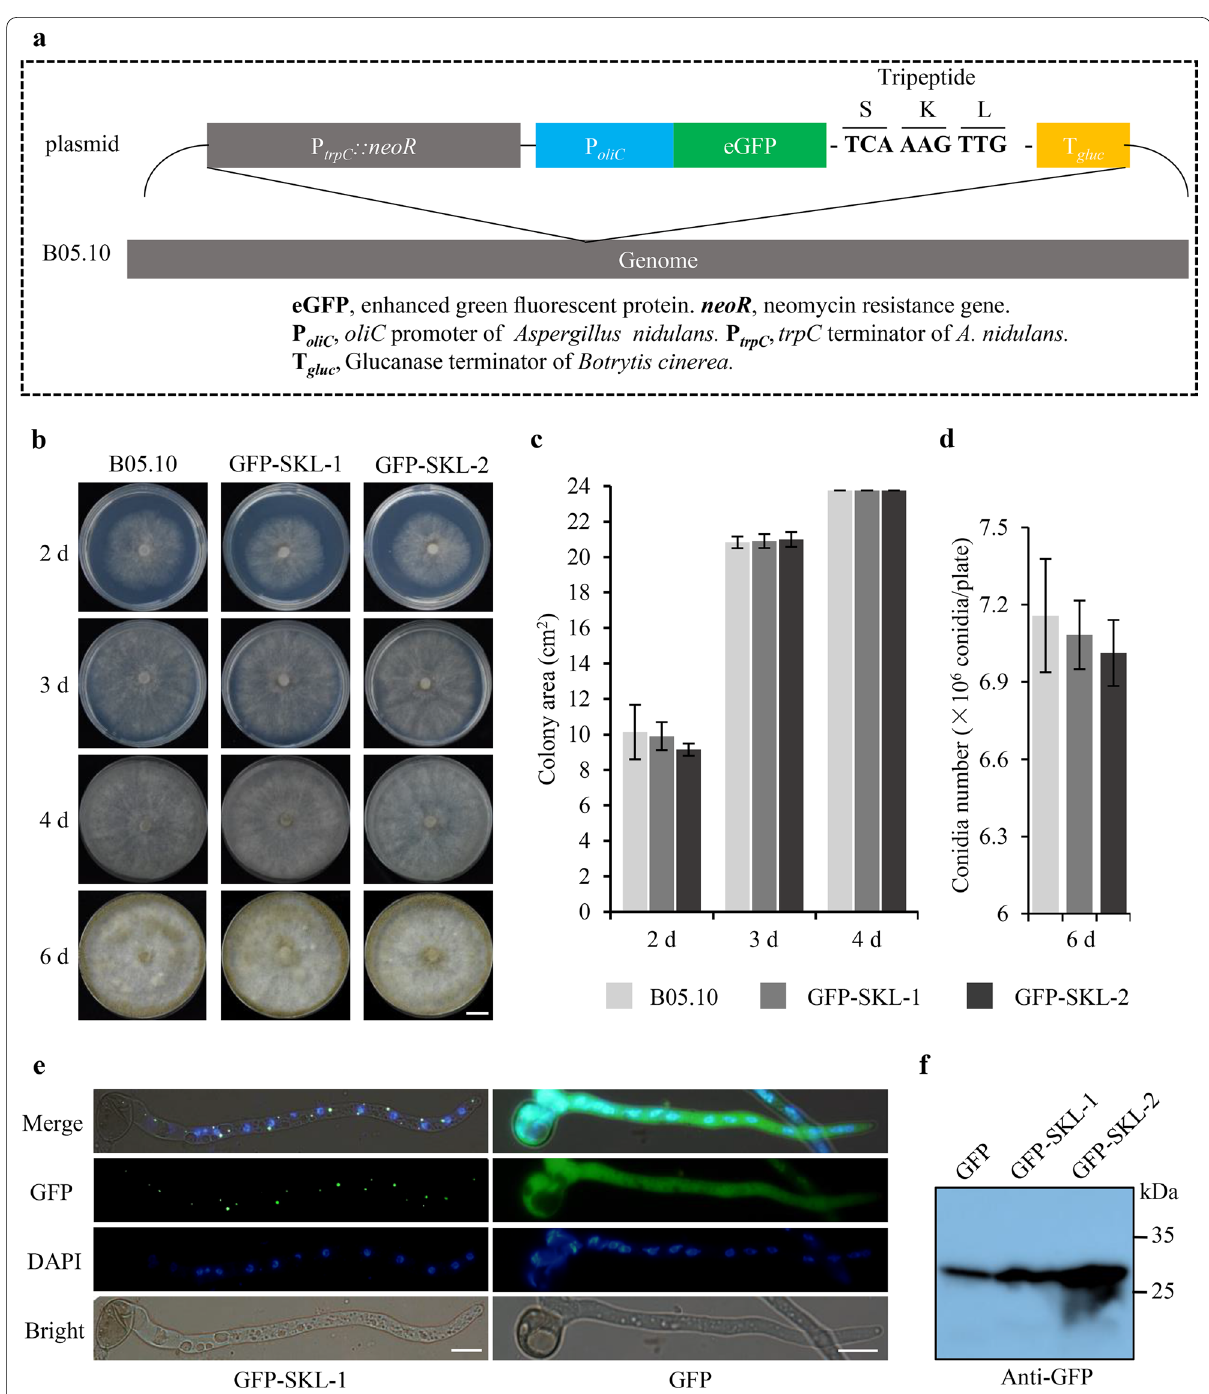
Fig. 3 Construction and phenotype of a B. cinerea strain expressing a peroxisome-localized marker. a Schematic diagram of the gene overexpression plasmid used for transformation of the B. cinerea strain B05.10. b Growth phenotypes of the wild-type strain B05.10 and its derivatives containing GFP-SKL at the indicated times. Bar 1 cm. c , d Colony area and conidia number of strains B05.10 and GFP-SKL-1/2 at the = indicated times. The values represent the average values, and the error bars indicate the standard deviations of three plates in one experiment. e Fluorescence signals produced by B. cinerea strains containing GFP-SKL or GFP only (GFP with no SKL tag). A fluorescence microscope with GFP channel and UV channel was used. Bar 10 μm. f Detection of GFP and GFP-SKL proteins expressed in B. cinerea by western blot assay using GFP = antibody. All experiments were repeated three times with consistent